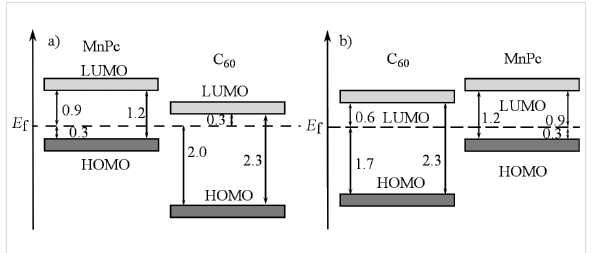
Figure 3: Schematic energy level diagrams of a) MnPc/C 60 , when C 60 is deposited onto MnPc and b) C 60 /MnPc, when MnPc is deposited onto C 60 . All values are given in